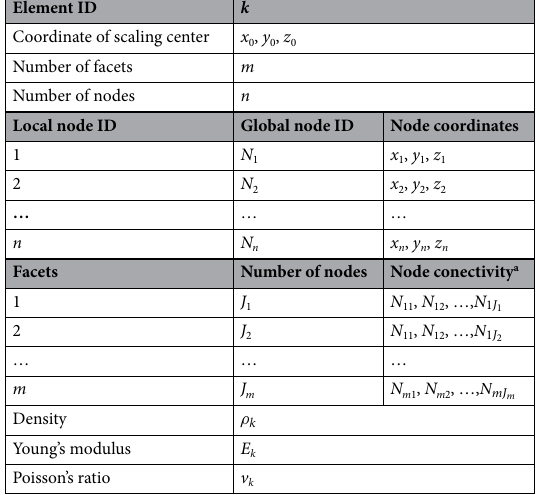
Table 3. Data structure of the SBFEM polyhedron element. a The node sequence should be in a certain order pointing out of the region according to the right-hand